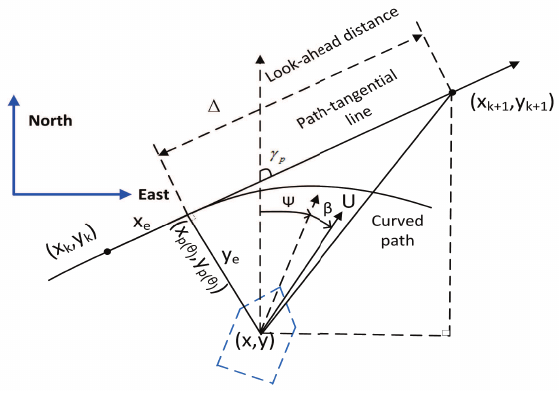
Figure 2. LOS guidance geometry for curved